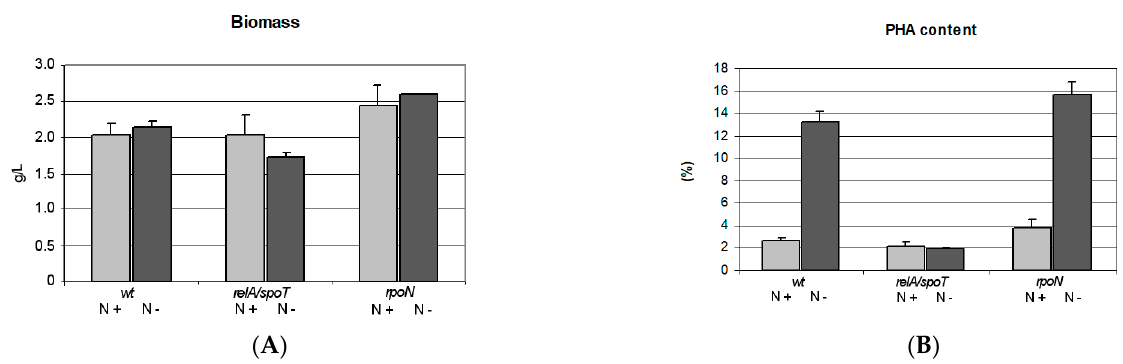
Figure 1. Cell dry mass ( A ) and PHA content ( B ) of wild type of Pseudomonas putida KT2440 and its relA/spoT and rpoN mutants. Shake flask cultivation was performed under optimal (N+) and nitrogen limiting conditions (N − ). Mean values with standard deviations are shown (n = 6).